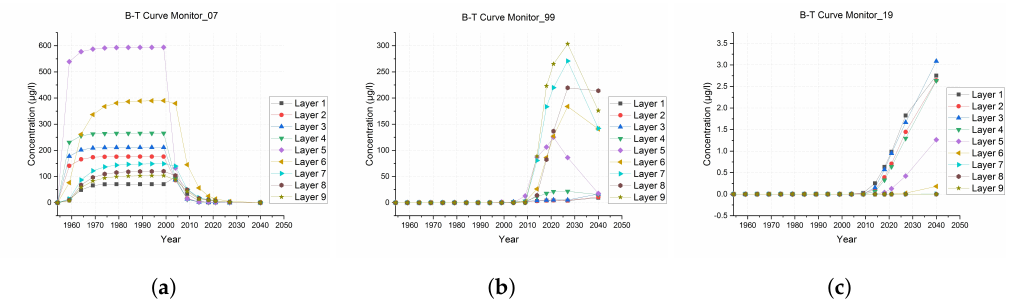
Figure 10. Breakthrough curves of the contaminant registered in ( a ) Monitoring Well 07, ( b ) Monitoring Well 99, and ( c ) Monitoring Well